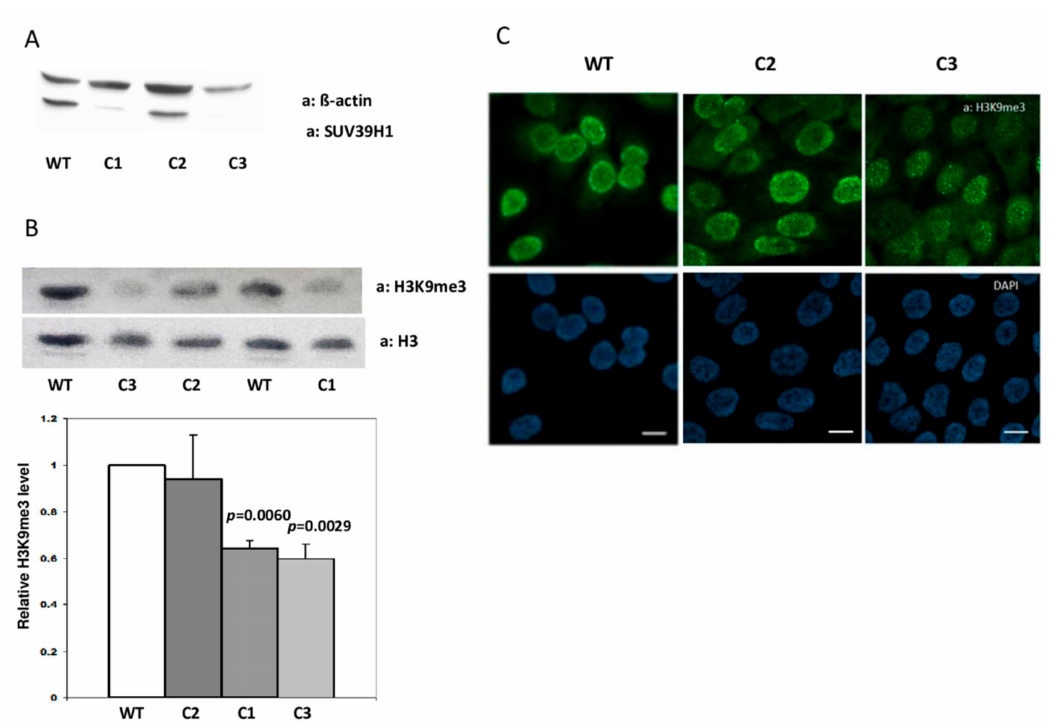
Figure 1. Characteristics of SUV39H1-KO HaCaT cells. ( A ) Representative Western blot showing expression of SUV39H1 in three single-cell clones (C1–C3) derived from HaCaT cells transfected with pCMV-Cas9-GFP plasmids. ( B ) Upper panel—representative Western blot showing the level of histone H3K9me3 in C1, C3 (SUV-39H1-KO mutation), C2 (no mutation), and WT HaCaT cells. Lower panel—statistical analysis of the results of n = 3 Western blots; bars represent mean ± SEM. ( C ) Representative confocal microscopy images of WT HaCaT cells and clones C2 (no mutation) and C3 (SUV39H1-KO mutation) stained for H3K9me3 (green). Nuclei are stained with DAPI (blue). Scale bar: 10 µ